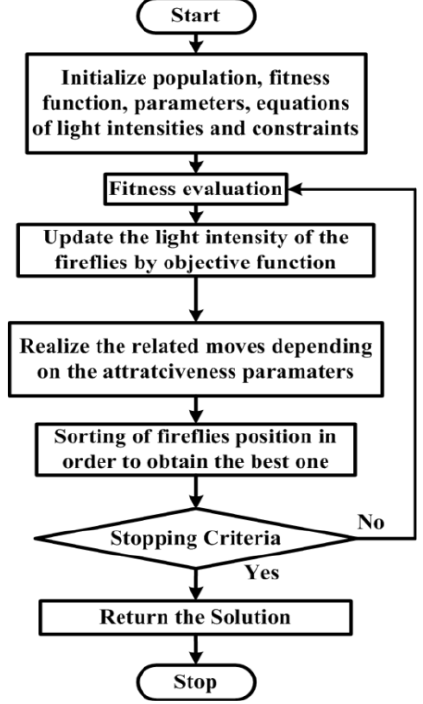
Figure 3. (a) Flowchart of Firefly